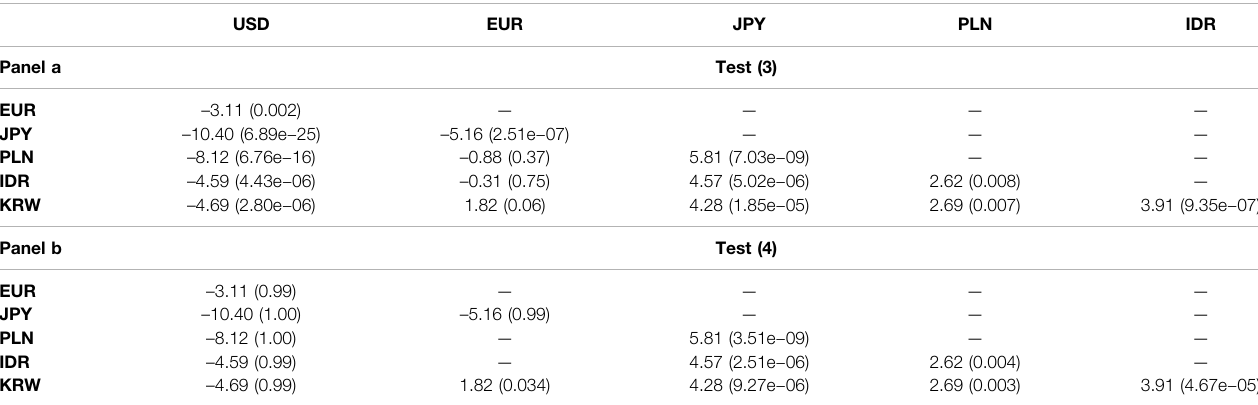
TABLE 4 | Test results of net pairwise spillover between good and bad volatilities USD EUR Panel